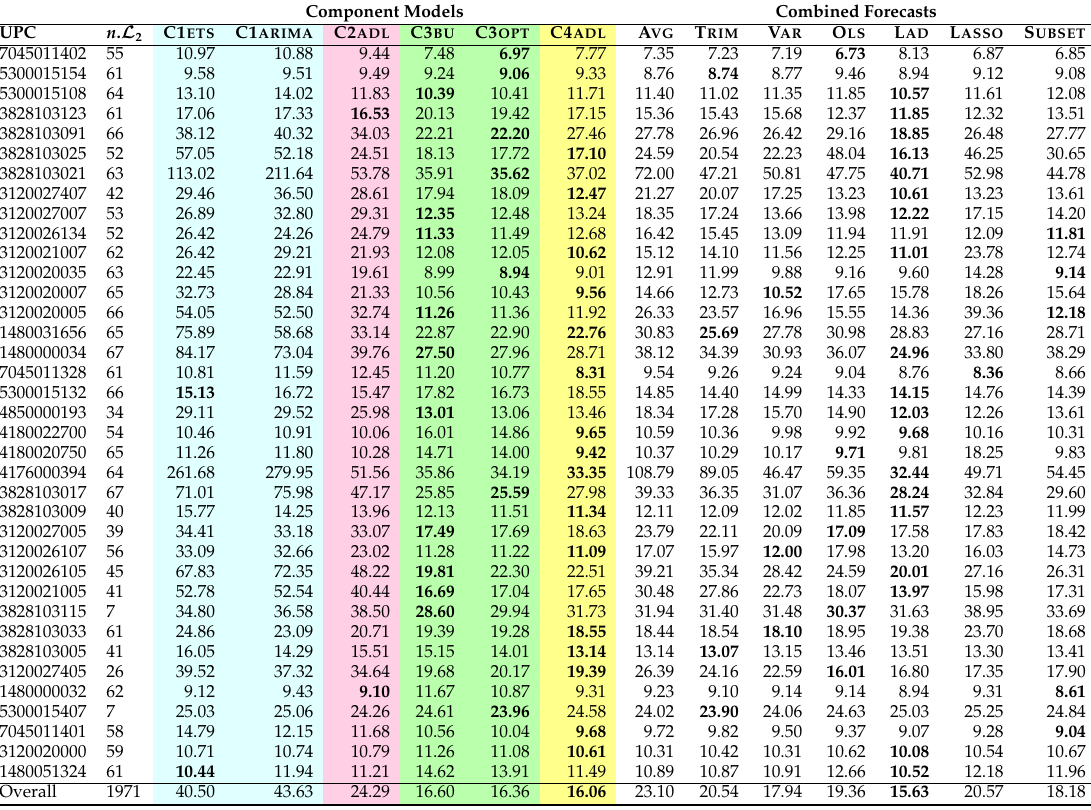
Table 1. Universal product code (UPC) level mean absolute percentage errors for the bottled juice category. The colored columns 3–8 compare forecast accuracies under different levels of information sharing, i.e., Cases I–IV. The combined forecasts using various methods are displayed in columns